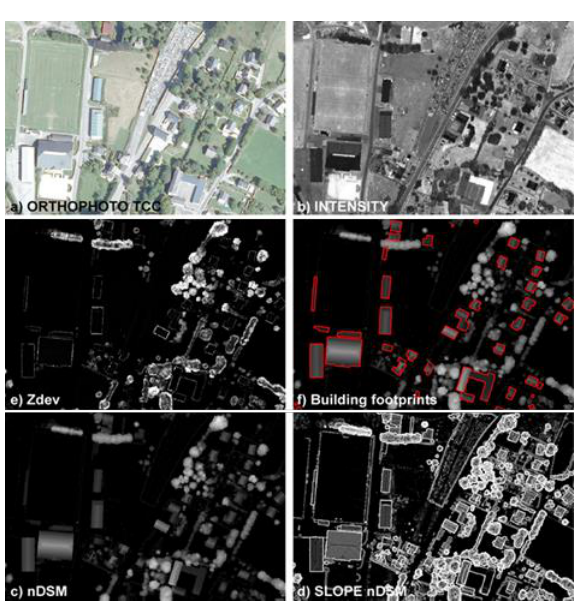
Figure 2. LiDAR metrics used (Van De Kerchove et al., 2015)